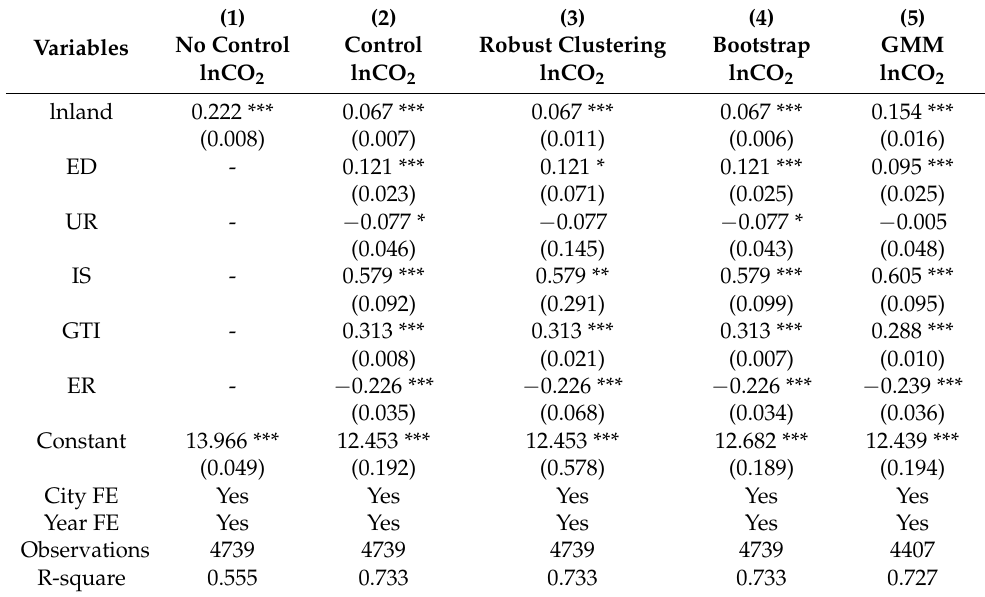
Table 2. The estimation results of the baseline